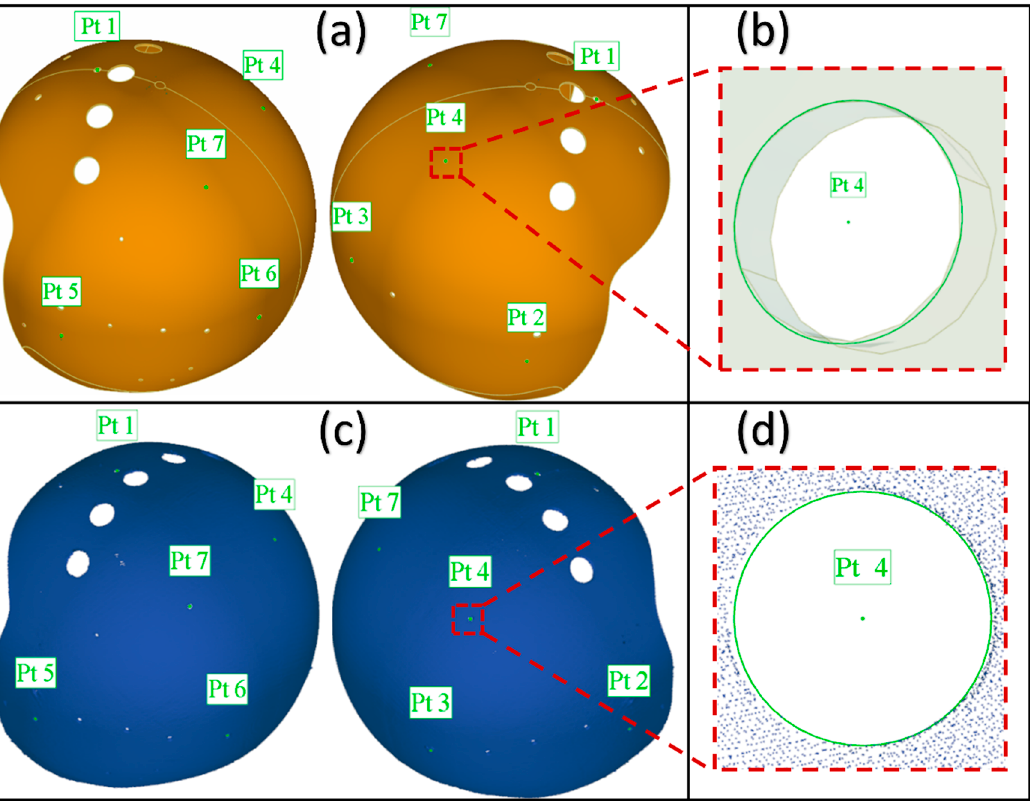
Figure 7. The central points of design model and point cloud model: ( a ) The location of central points in CAD model; ( b ) Central point obtaining in CAD model; ( c ) The location of central points in point cloud model; ( d ) Central point obtaining in point cloud model.